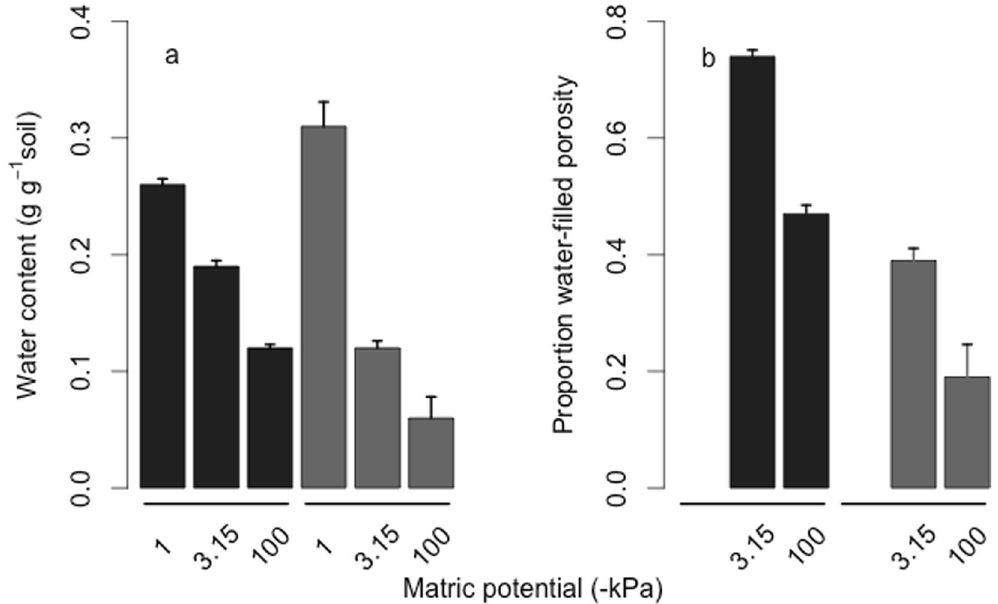
Figure 1. Water-filled pore volumes in the silty (black) and sandy (grey) soils at saturation and at the two incubation matric potentials ( a ), and the proportion of water-filled pores in the pore network of the silty (black) and sandy (grey) soils ( b ). Error bars are standard error of the mean (n =